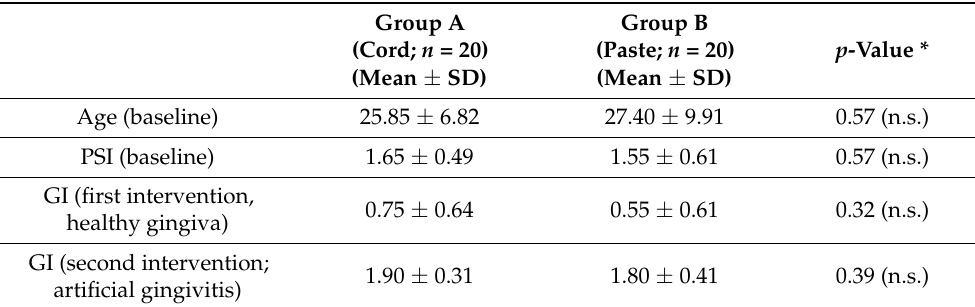
Table 1. Demographic and clinical characteristics for group A (cord) and group B (paste); * one-sample t -Test for dependent samples (Variance homogeneity (Levene) given); PSI: Periodontal